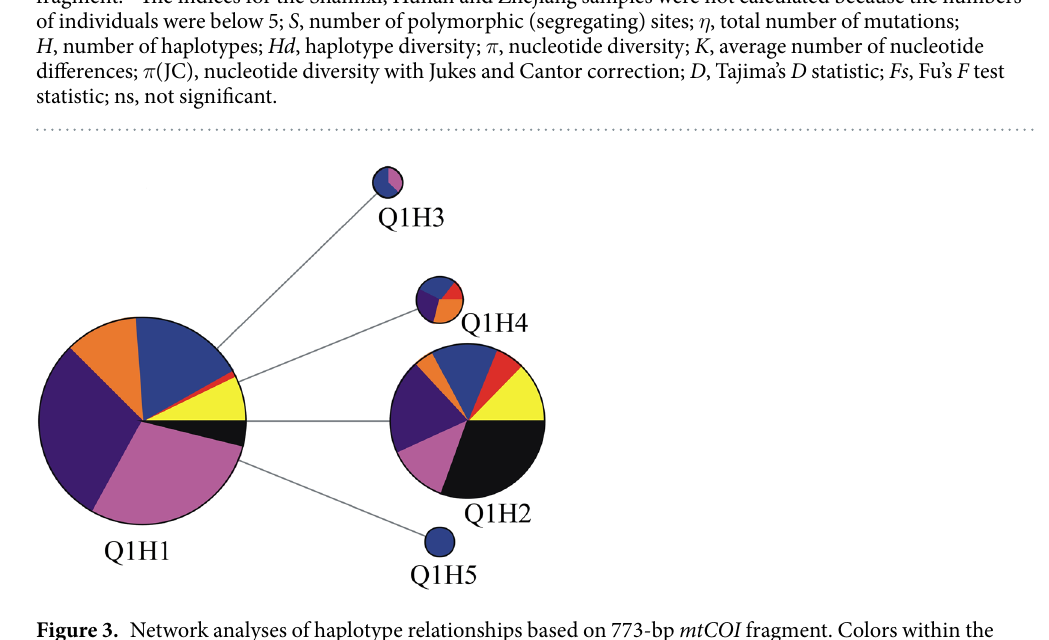
Figure 3. Network analyses of haplotype relationships based on 773-bp mtCOI fragment. Colors within the nodes: red, Southeastern China; orange, Central China; yellow, Northwestern China; purple, Northeastern China; blue, Northern China; pink, Eastern China; black, Southern